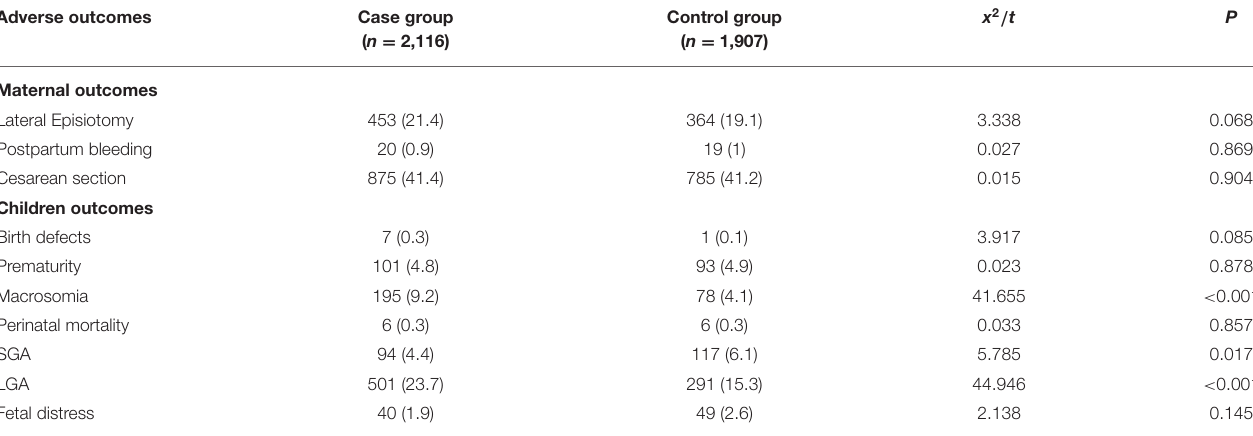
TABLE 3 | Adverse outcomes of participants and offspring according to late pregnancy blood glucose among the total